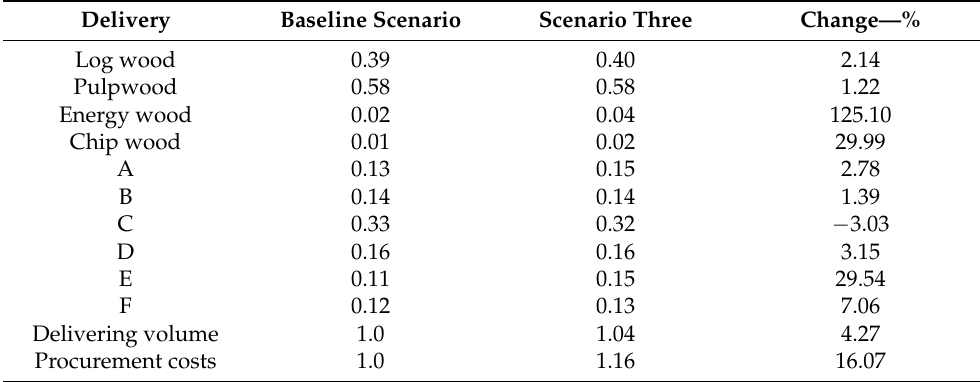
Table 3. Changes in wood deliveries and total costs of wood procurement regions (A–F) in scenario three, “extensive energy reform”.